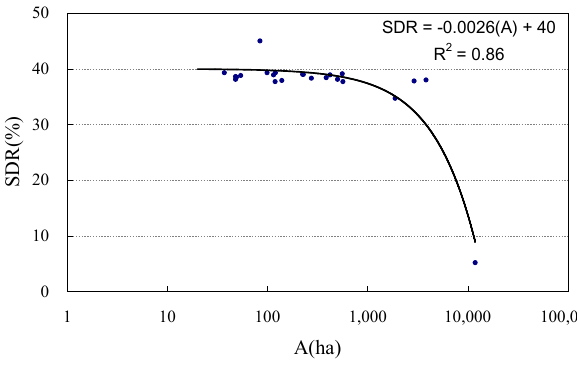
Figure 9. Relationship between sediment delivery ratio and watershed area 621 Fig. 9. Relationship between sediment delivery ratio and watershed